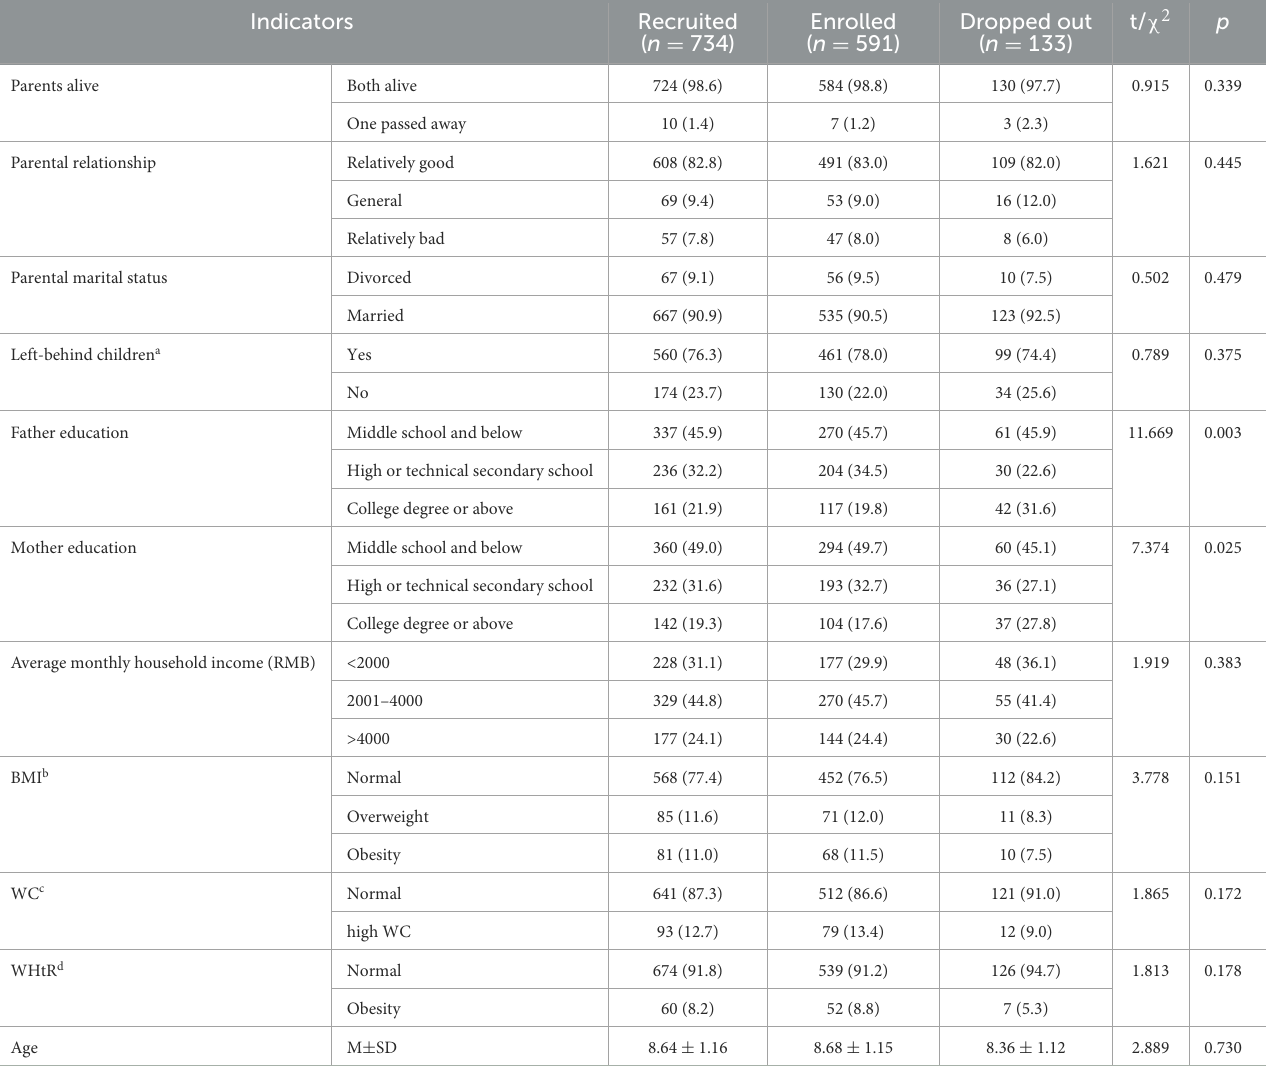
TABLE 1 Comparison of characteristics and physical examination of enrolled and dropped-out girls before